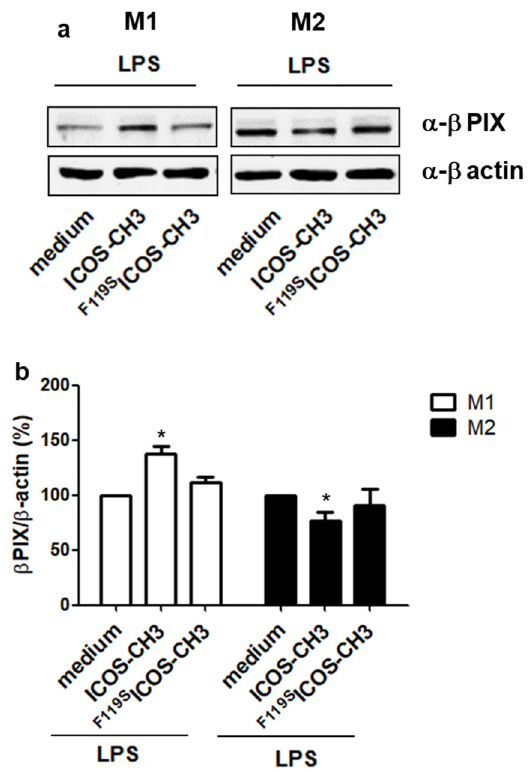
Figure 6. Downstream effects of ICOSL activation in M1 vs. M2 cells. Differentiated M1 and M2 MDMs were treated or not with the indicated ICOS reagents for 30 min at T6 + 2. Expression of β -Pix was assessed by Western blot. The same blots were also probed with an anti– β -actin Ab as a loading control. The upper panel ( a ) shows a representative experiment. The bar graph ( b ) shows the densitometric analyses of the gels referred to as the relative internal control. Data are expressed as mean, and SEM of the percentage of increase vs . control set at 100% from three independent experiments. * p < 0.05, vs. control.